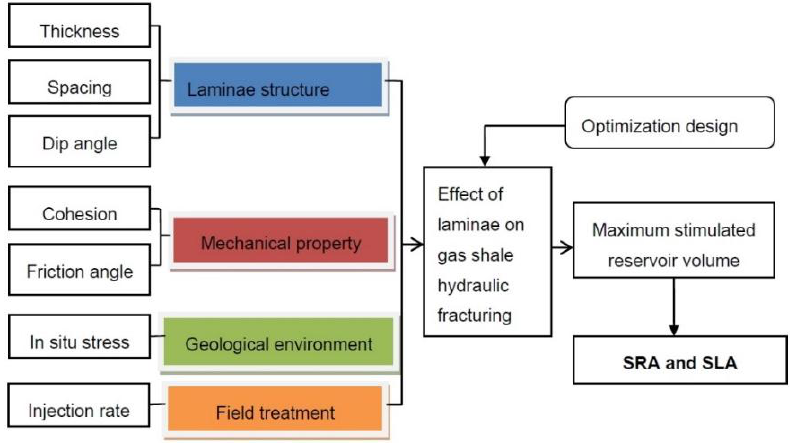
Figure 1. The typical shale core with silty laminae from Chang 7-3 member: ( a ) outcrop of silty laminae in a Chang 7 stratum; and ( b )core sample of Chang 7 formation with typical silty laminae structure.